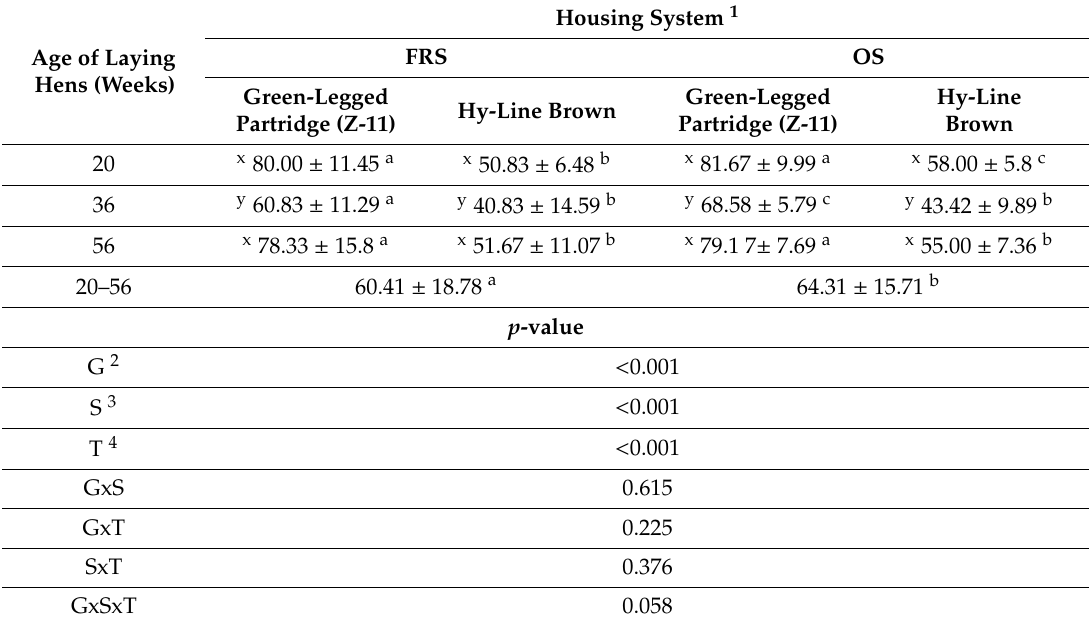
Table 2. Percentage of hens using the